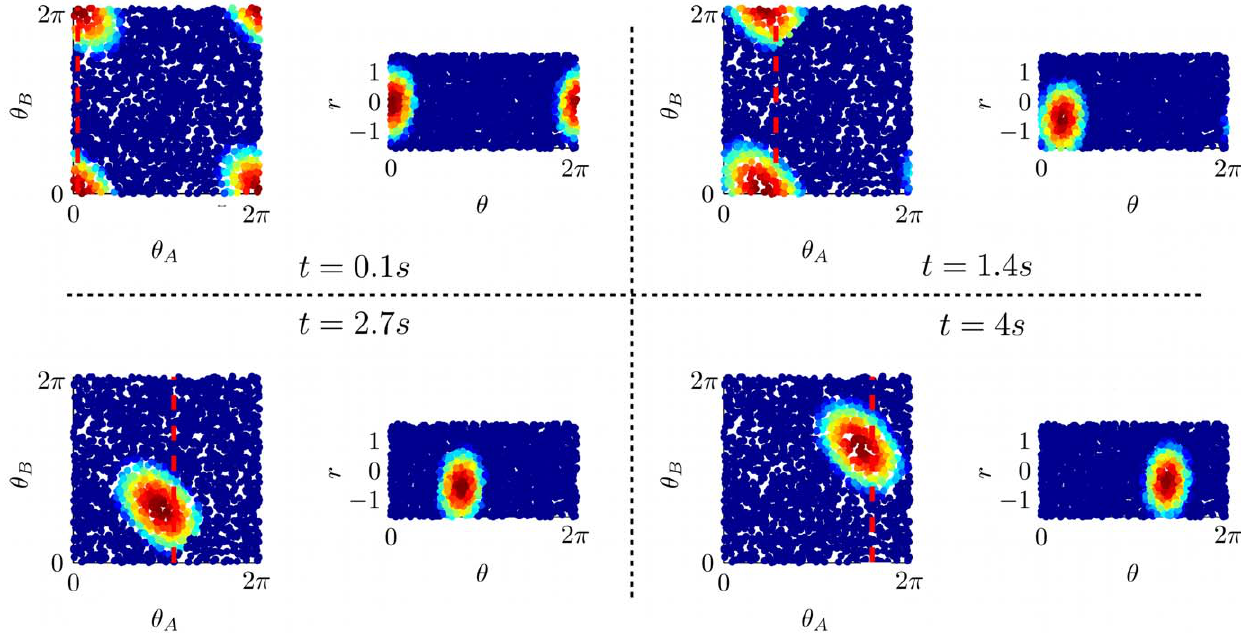
Figure 10. Dynamical pattern separation for a network storing a finite number of maps along the morph sequence. Sequence of snapshots of the network activity, in h A , h B ð Þ and h , r ð Þ coordinates. The network with N ~ 2000 neurons is storing p ~ 11 maps, equally spaced along 2 p t . Each dot represent a neuron, with color coded activity. The the morph sequence. The external input is localized in map A and evolves as Y t ð Þ ~ 5 dashed red line represents the maximum of the external tuned input. As the activity evolves in time from a random configuration, the subset of active neurons moves towards the negative r region and stays there moving only along h . The parameters are J 1 ~ 30, J 0 ~{ 30, ~ 0 : 1 ð